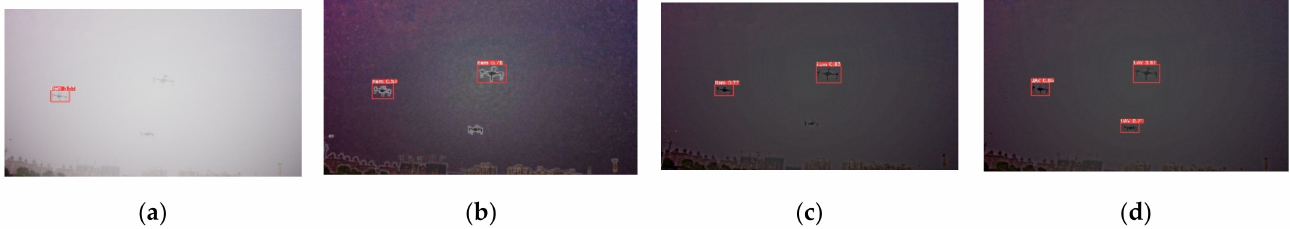
Figure 14. Tracking effects with different algorithms. ( a ) Method 1; ( b ) Method 2; ( c ) Method 3; ( d ) Method 4.